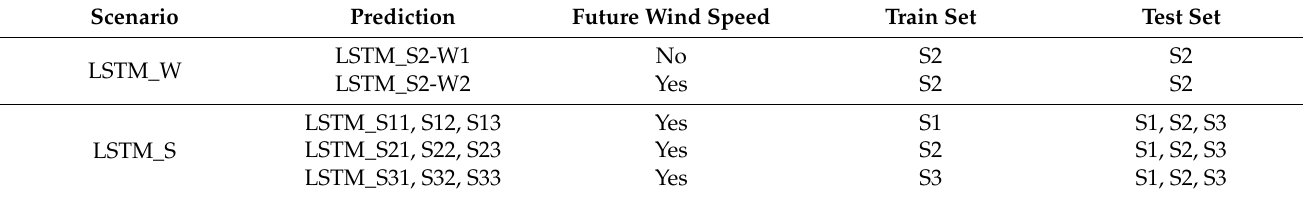
Table 1. Wind field (LSTM_W) and station (LSTM_S) scenarios used in model experiments. Scenario